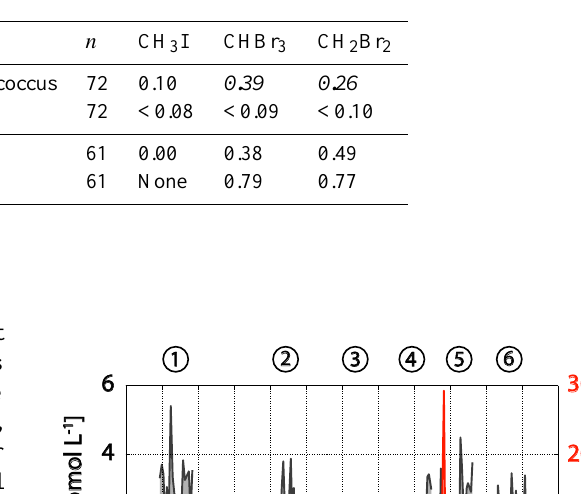
Table 3. Correlation coefficients R 2 of halocarbons to nano- and picoplankton abundances as well as to phytoplankton pigment data (MLR – Multiple Linear Regression). The correlations to Prochlorococchus are all significant on the p <0.05 level. Negative correlations are printed in italic.